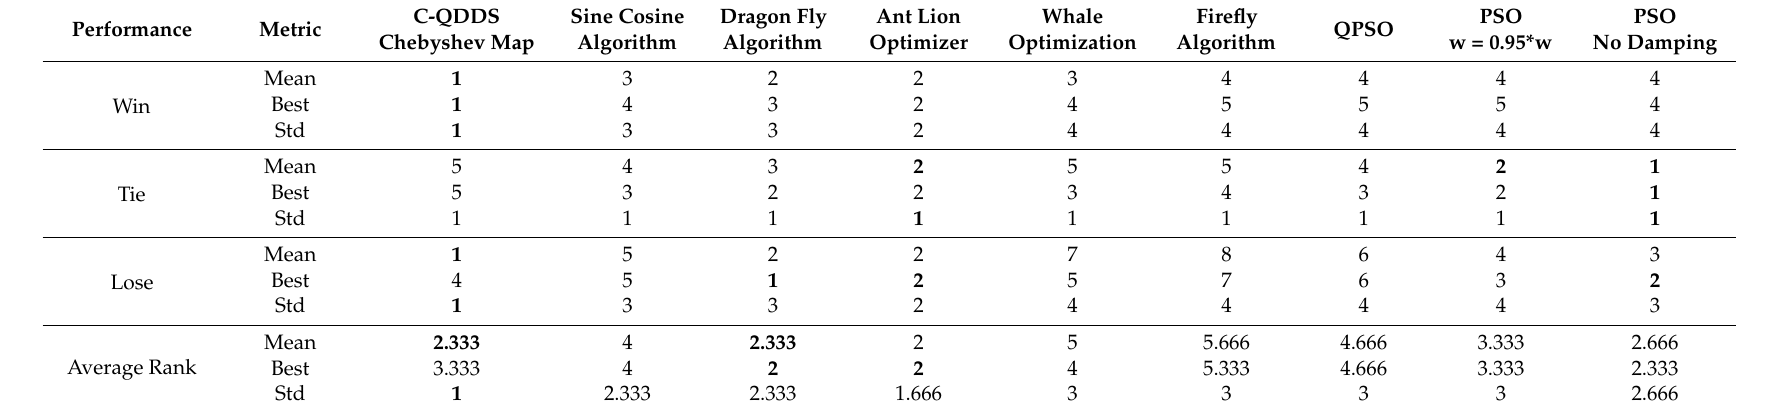
Table 14. Average ranks based on win/tie/loss count among competitors w.r.t. reported global